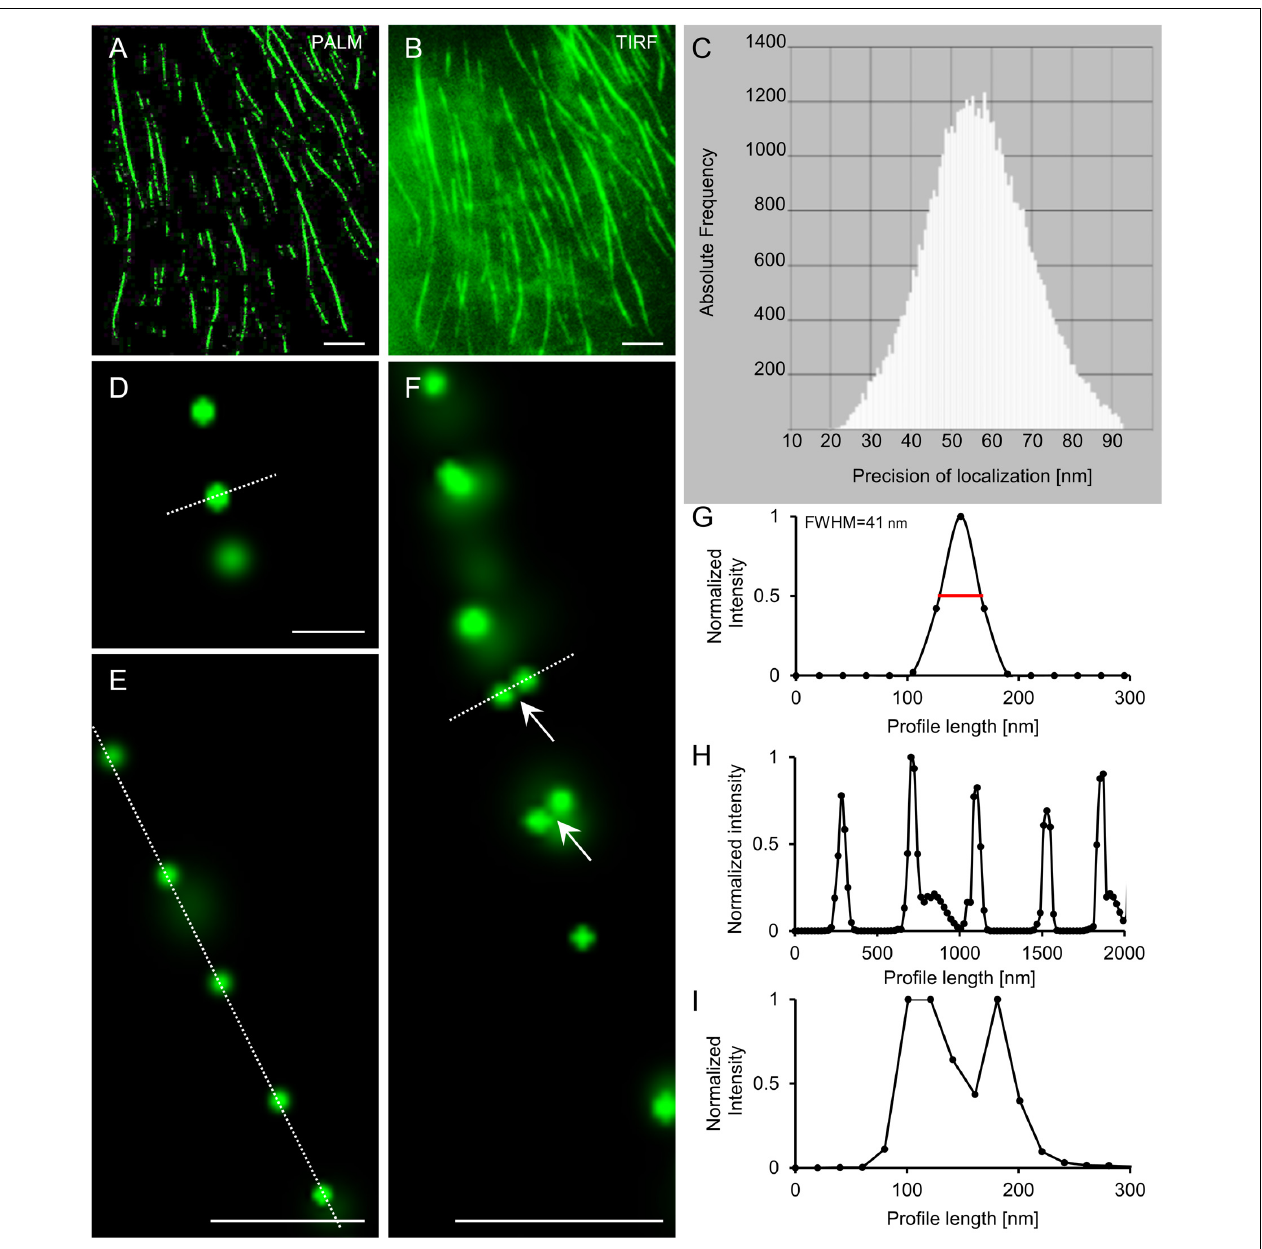
FIGURE 11 | PALM localization of mEos3.2-MAP65-2. (A,B) Overview of Arabidopsis hypocotyl epidermal cell expressing mEos3.2-MAP65-2 at the end of an acquisition time series following single molecule localization by PALM (A) or TIRF imaging (B) . (C) Histogram of photon detection frequencies plotted against precision of localization. (D–F) Details from PALM imaging in (D) are single mEos3.2-MAP65-2 molecule; (E) shows a linear array of single mEos3.2-MAP65-2 molecules; and in (F) is a linear array of mostly mEos3.2-MAP65-2 molecules with two pairs of spots most likely corresponding to mEos 3.2-MAP65-2 dimers. (G) Normalized intensity profiling of the spot delineated with the dotted white line in (D) , showing a full-width at half maximum (FWHM) of ca. 41 nm. (H) Normalized intensity profiling corresponding to the dotted white line in (E) , showing the periodic distribution of mEos3.2-MAP65-2 along a microtubule bundle. (I) Normalized intensity profiling along the dotted white line of (F) . Scale bars = 5 µ m (A,B) ; 0.2 µ m (D) ; 0.5 µ m (E,F)